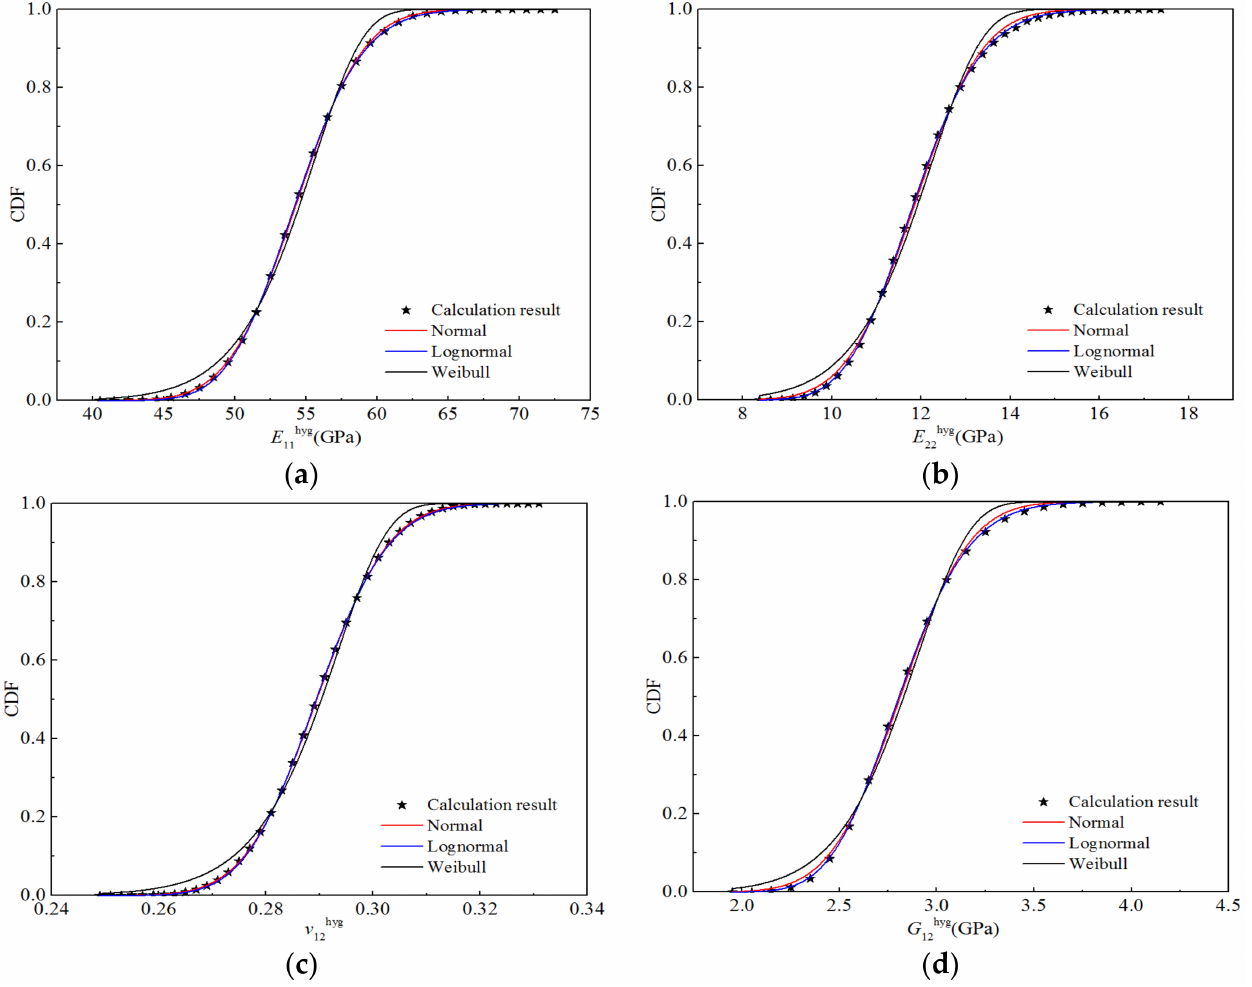
Figure 21. Function fitting curves for the stiffness of H-GFRPs under the ETW condition. ( a ) E 11 , ( b ) E 22, ( c ) v 12 , ( d ) G 12